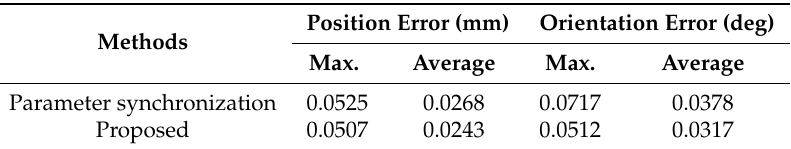
Table 3. Fitting error of the experiments.